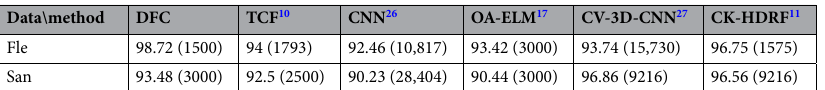
Table 8. Comparison of DFC with other classification